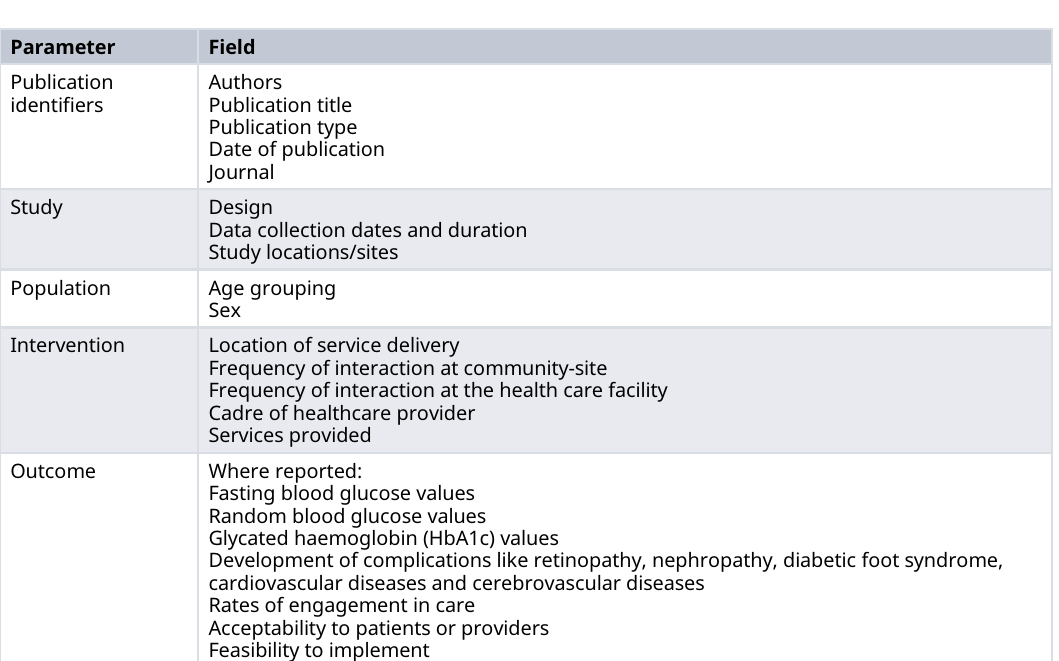
Table 4. Fields to be extracted from included